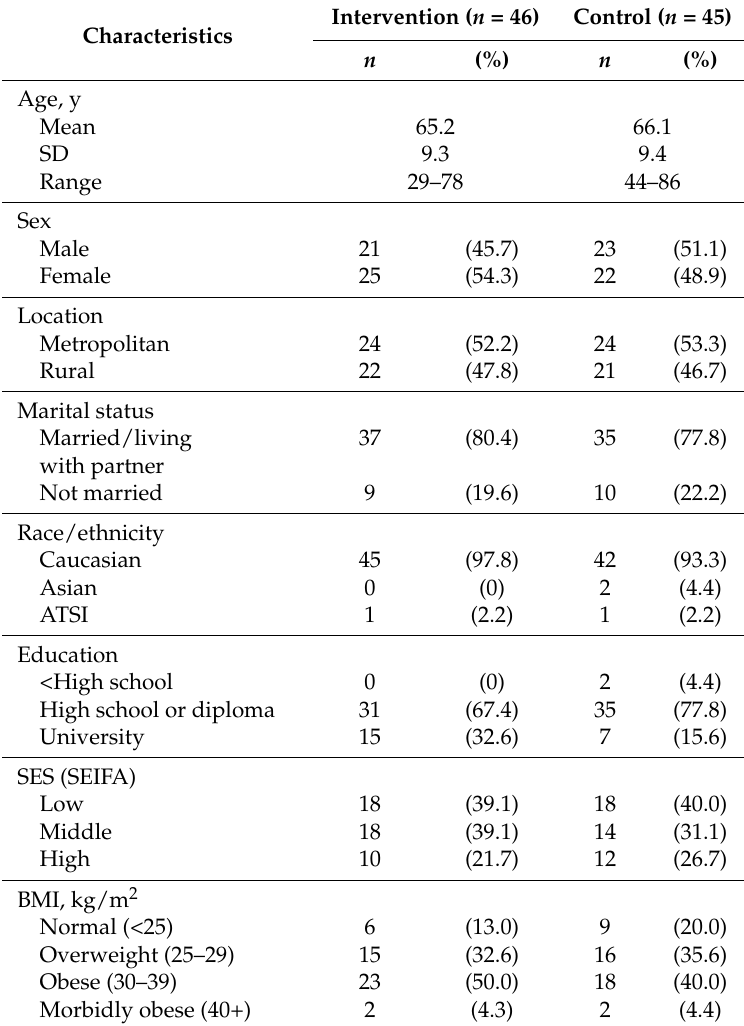
Table 1. Socio-demographic and health characteristics of